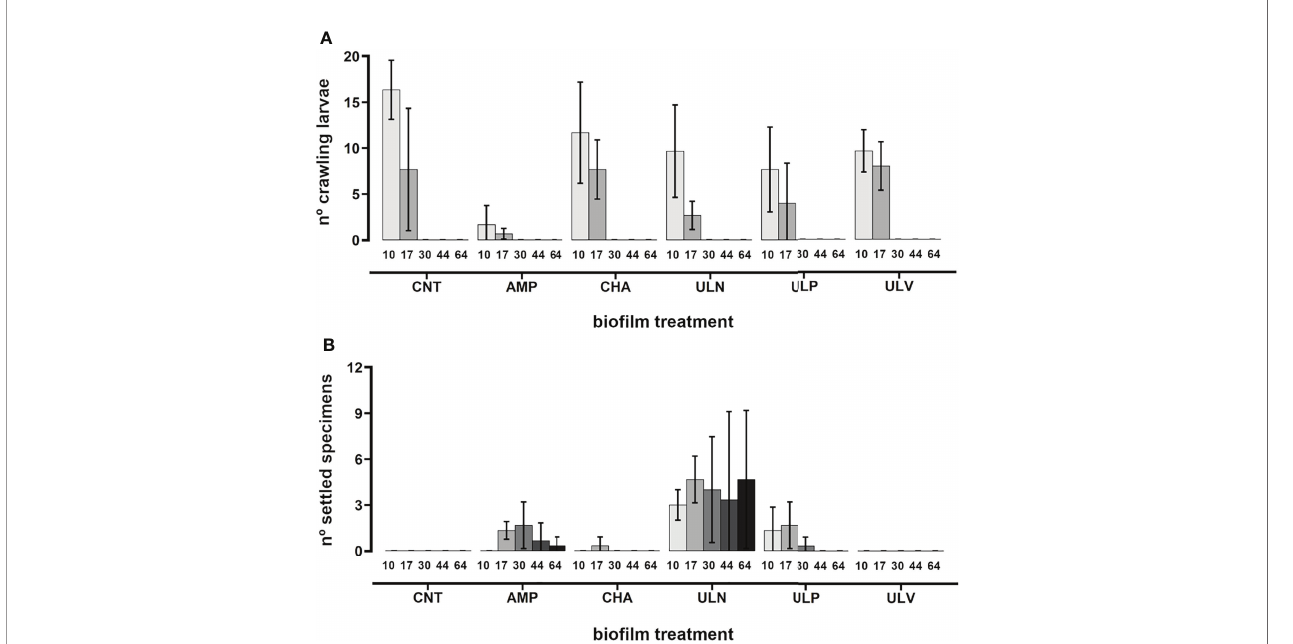
FIGURE 12 | P. candei . In fl uence of different cultured algal strains on the settlement (study realized in Azores). Pediveliger larvae (no. of crawling pediveligers (A) and metamorphosed post-larvae and juveniles (no. of settled specimens (B) recorded during different days post-fertilization (10, 17, 30, 44, and 64 days) on different cultured algal bio fi lms. Bars indicate average ± SD. AMP, diatom Amphora sp.; CHA, diatom Chaetoceros sp.; CNT, negative control treatment; ULN, chlorophyte Ulvella lens ; ULP, chlorophyte Ulvella leptochaete ; ULV, chlorophyte Ulva